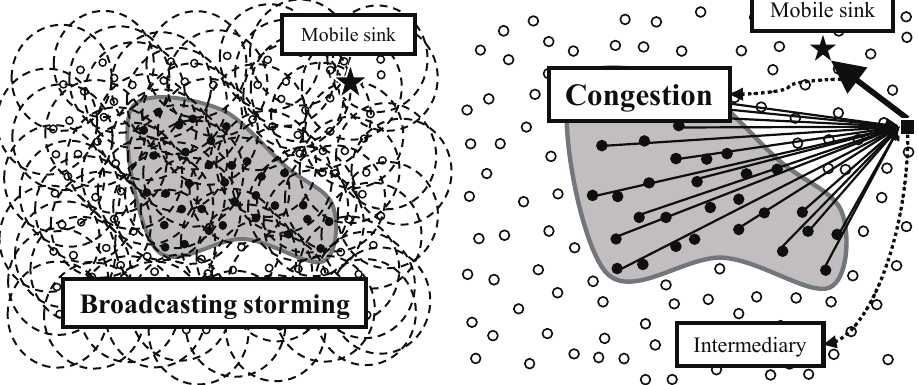
Figure 2. Intuitive solutions for supporting sink mobility: ( left ) Flooding-based approach and ( right ) Intermediary-based